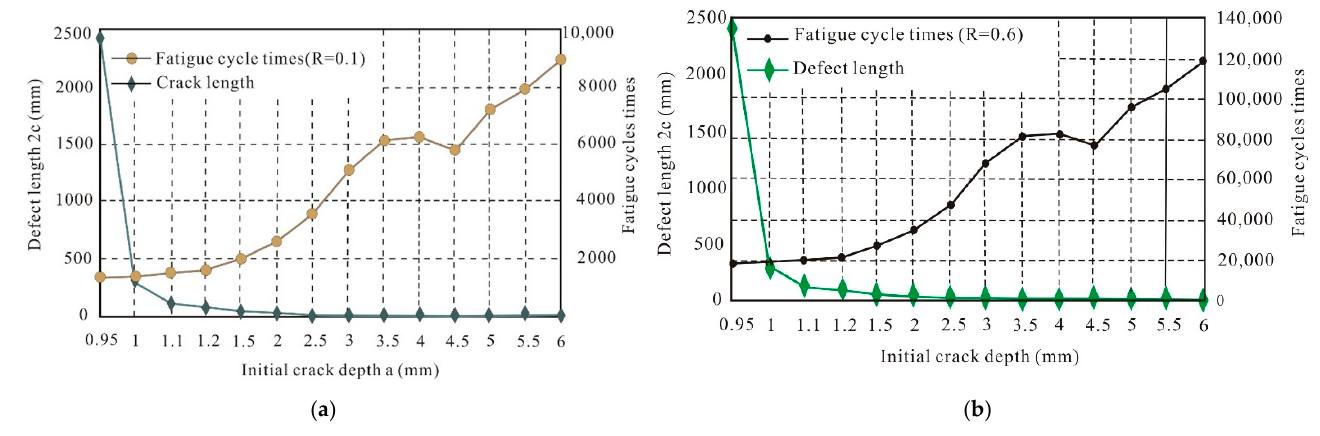
Figure 20. Relationship between pipeline cycle times and initial crack depth ( a ) R = 0.1; ( b ) R = 0.6.